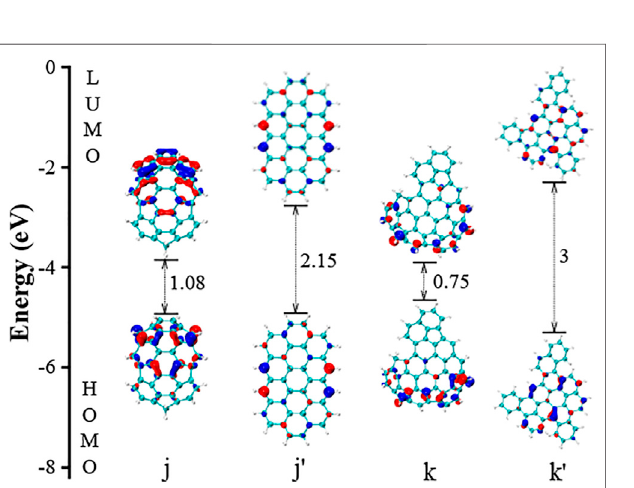
FIGURE 9 | The HOMO and LUMO electronic structures of two planar PAHs ( l and m ). The l ’ is a coronene having two more hydrogens compared to l. The m ’ ismadefrom replacing two fi ve-member rings withsix-member rings in m . The m ’’ is made from replacing all fi ve-member rings with six- member rings in m